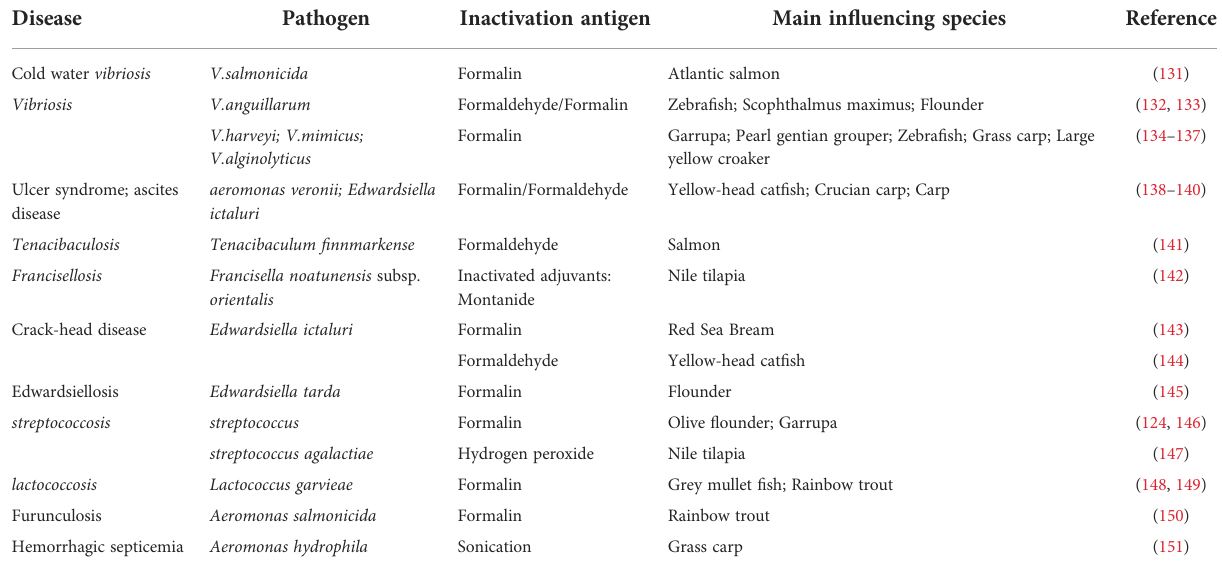
TABLE 4 Inactivated Bacterial